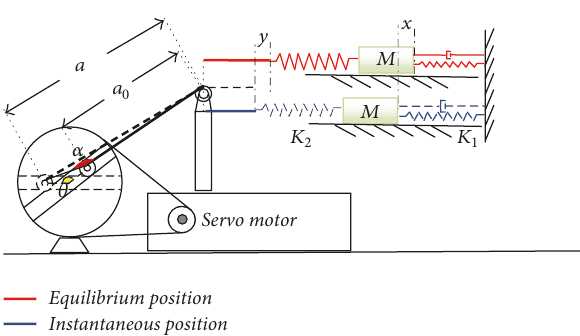
Figure 2: Schematic diagram of vibration test system with large motion amplitude and force